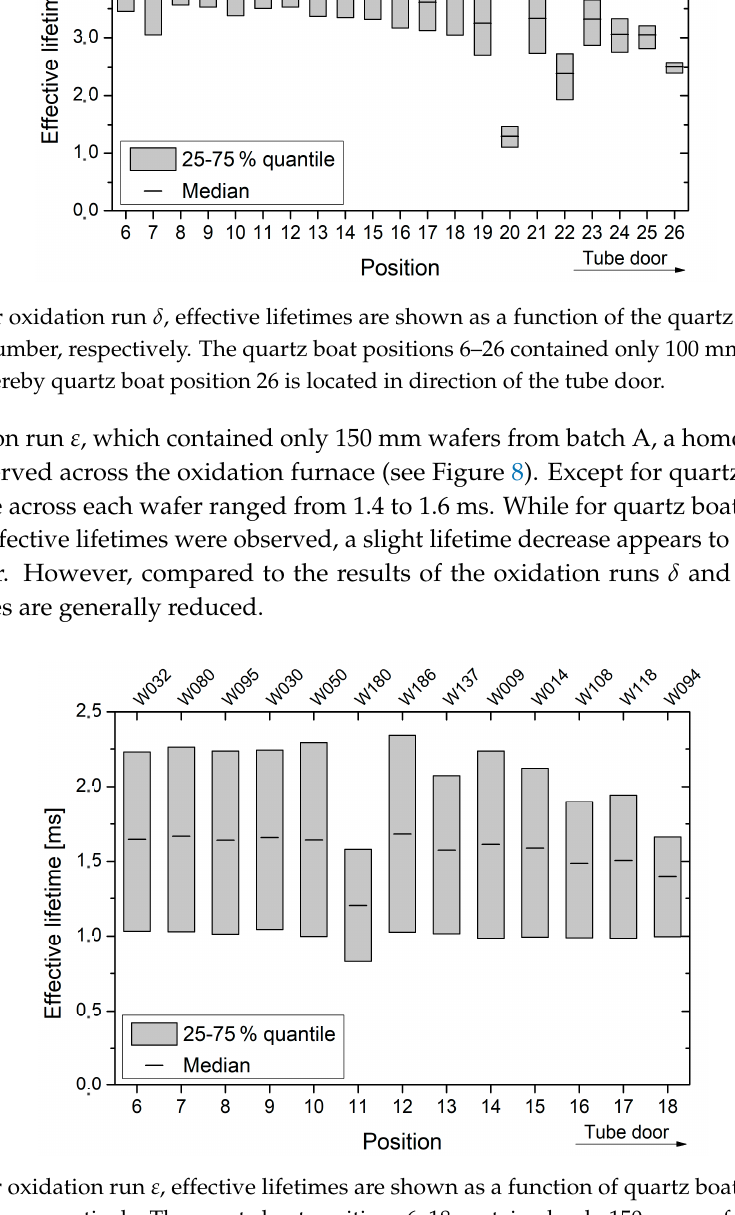
Figure 6. For oxidation run γ , effective lifetimes are shown as a function of the quartz boat position and wafer number, respectively. The quartz boat positions 6–21 contained only 150 mm wafers from batch B, whereby quartz boat position 21 is located in direction of the tube door.